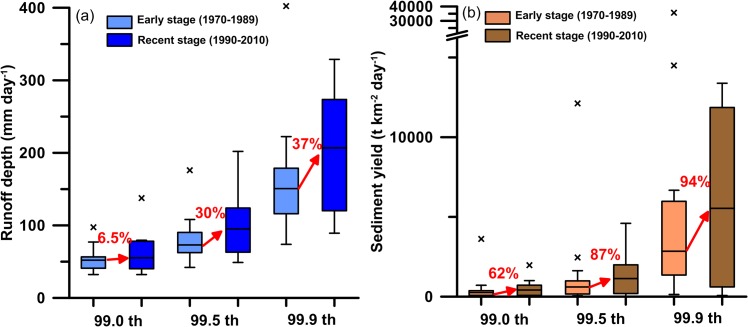
The changes of the 99.0-, 99.5-, and 99.9-percentile of (a) runoff depth and (b) sediment yield between the early stage (1970–1989, shown in lighter blue and brown boxes) and the recent stage (1990–2010, shown in darker blue and brown boxes).Each box-whisker contains values from the 16 rivers. Both runoff and sediment yield extremes have increased in the recent stage compared to the early stage.